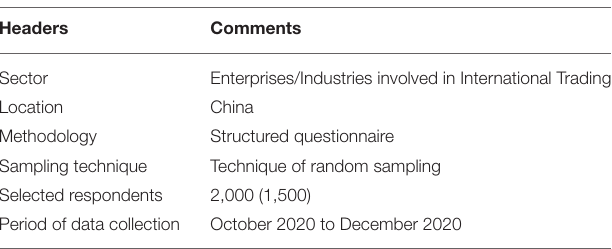
TABLE 1 | Research